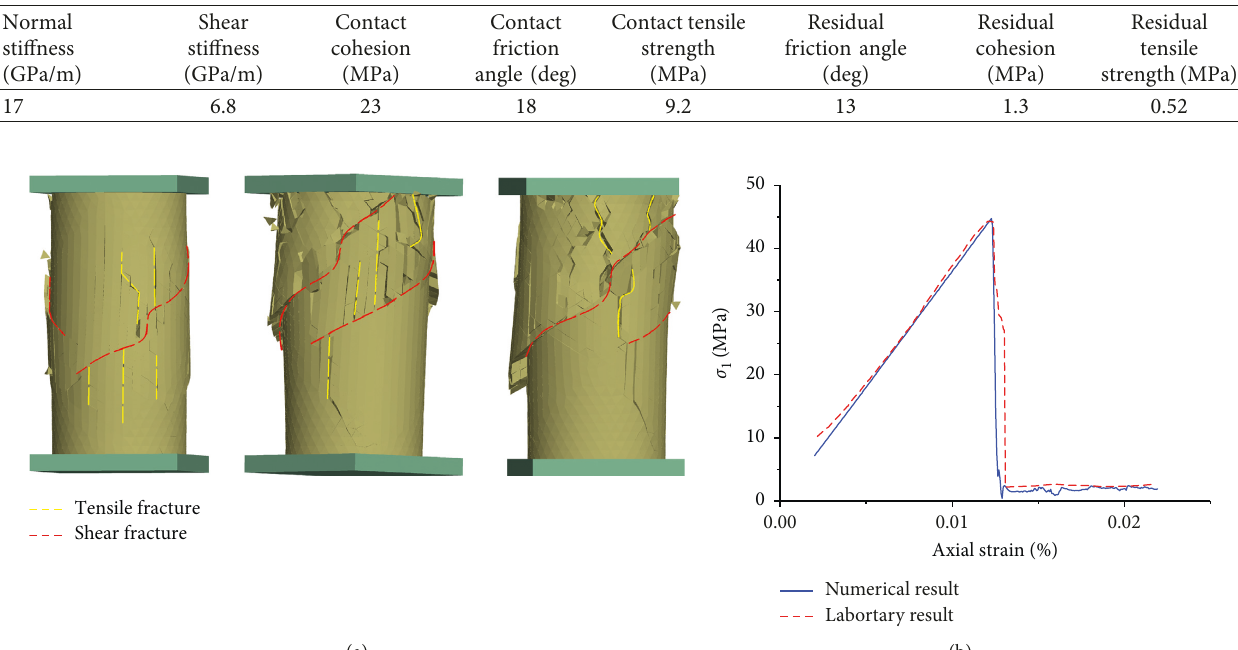
Table 2: Calibrated microcontact properties assigned to 3DEC bonded block model.